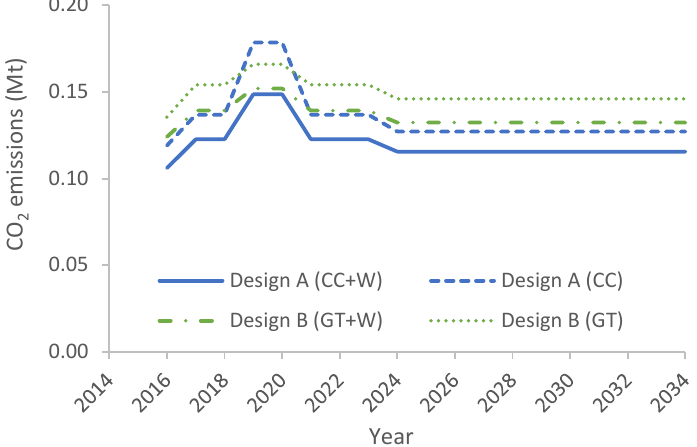
Figure 10. Annual CO 2 emissions for the concepts analysed: Design A (CC+W), Design A (CC), Design B (GT+W) and Design B (GT).